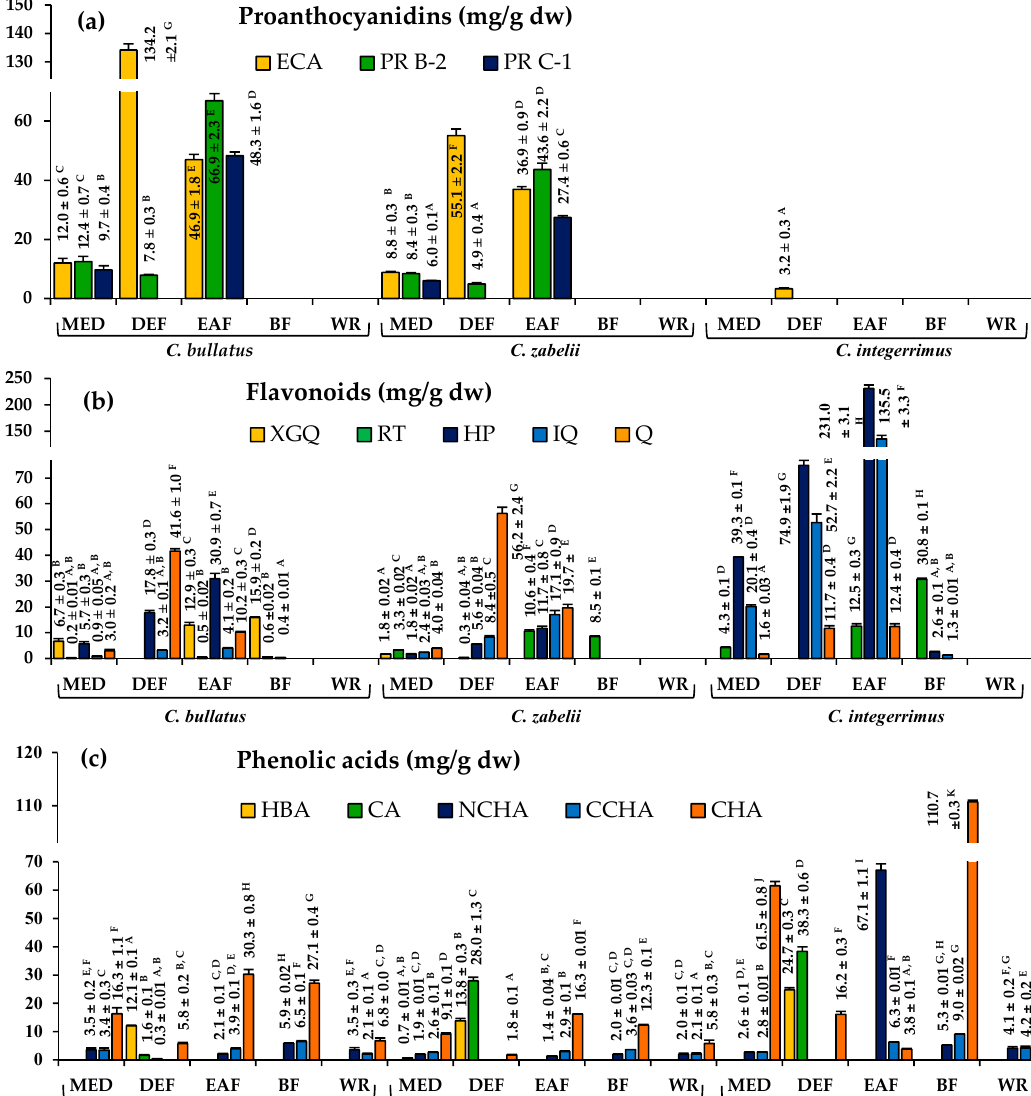
Figure 2. Quantitative profiles of Cotoneaster leaf extracts determined by HPLC-PDA: ( a ) the content of individual proanthocyanidins (mg/g dw of the extracts): ECA, ( − )-epicatechin; PR-B2, PR-C1, procyanidins B-2 and C-1, respectively; ( b ) the content of flavonoids (mg/g dw): XGQ, quercetin 3-(2”-xylosyl)-galactoside; RT, rutin; HP, hyperoside; IQ, isoquercitrin; Q, quercitrin; ( c ) the content of phenolic acids (mg/g dw): HBA, the sum of hydroxybenzoic acids; CA, caffeic acid; NCHA, 3- O -caffeoylquinic acid; CCHA, 4- O -caffeoylquinic acid; CHA, 5- O -caffeoylquinic acid (chlorogenic acid), respectively. Extracts: MED, methanol-water (7:3, v / v ) extract; DEF, diethyl-ether fraction; EAF, ethyl acetate fraction; BF, n -butanol fraction; WR, water residue. Data expressed as mean values ± SD ( n = 3). For each analyte, different superscript capitals indicate significant differences ( p < 0.05).